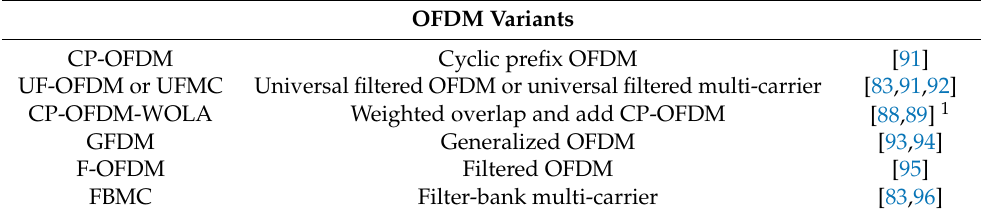
Table 4. MIMO-OFDM